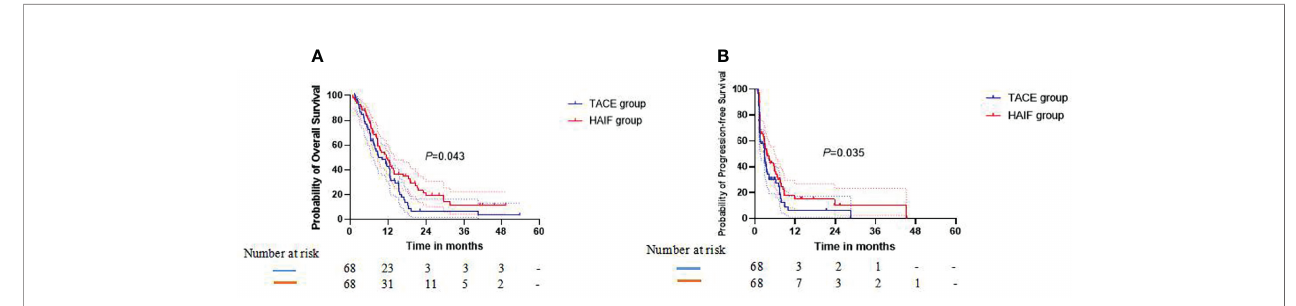
FIGURE 3 | In the propensity score matching (PSM)-adjusted Kaplan-Meier analyses, (A) graph showing that the 1-, 2-, and 3-year cumulative OS rates in the TACE group are lower than in the HAIC group (P = 0.043). (B) Graph showing that the 1-, 2-, and 3-year cumulative PFS rates in the TACE group are lower than in the HAIC group (P = 0.035).